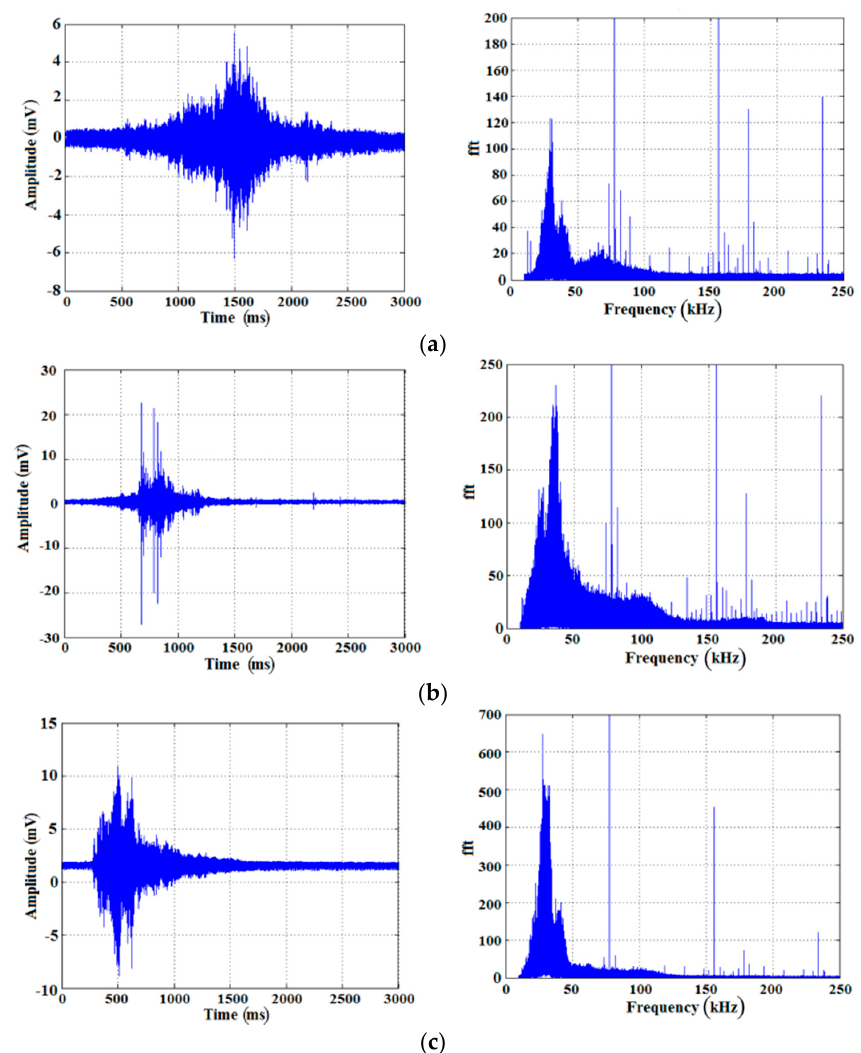
Figure 6. Acoustic emission (AE) signals from passing vehicles: ( a ) Zone I; ( b ) Zone II; ( c ) Zone III.